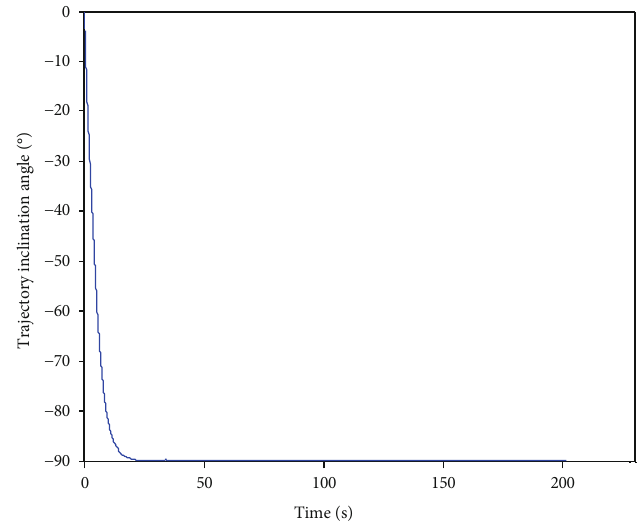
Figure 8: Trajectory inclination angle-time diagram.